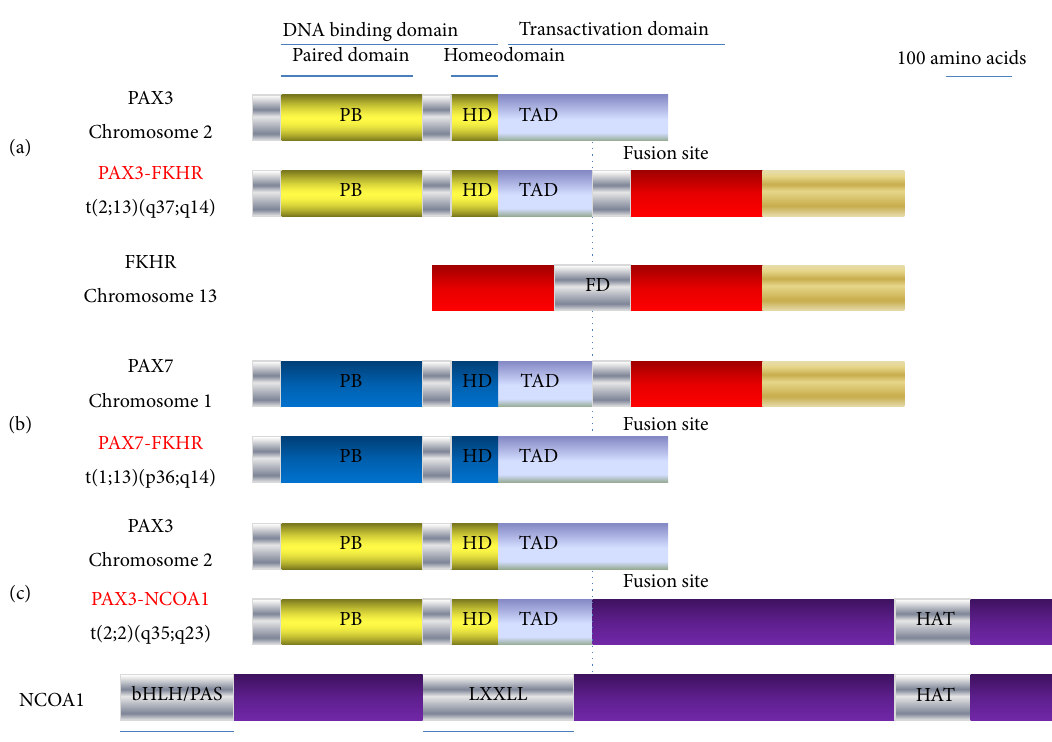
Figure 1: The chromosomal rearrangements in ARMS. 80% of ARMS classified as translocation-positive ARMS carry characteristic chromo- somal translocations demonstrated as t(2;13)(q35;q14), t(1;13)(p36;q14), and (2;2)(q35;p23). In (a) and (b), the translocations fuse the FKHR (a member of the forkhead/HNF-3 transcription factor family) locus on chromosome 13 to either PAX3 on chromosome 2 or PAX7 on chromosome 1. In (c), the translocation generated a fusion protein composed of PAX3 and the nuclear receptor coactivator NCOA1, having similar transactivation properties as